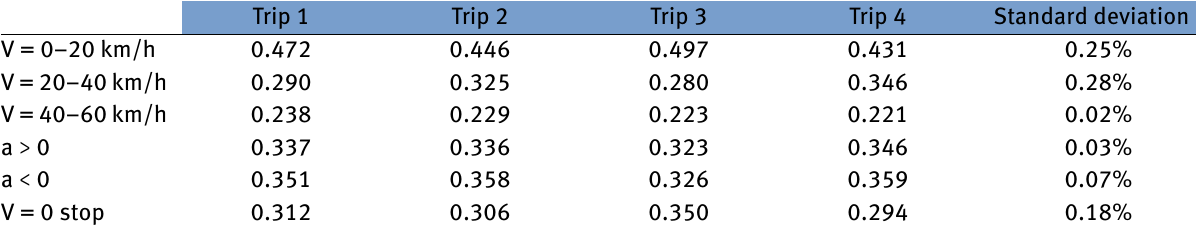
Table 3: Comparison of travel parameters of a bus trip with a diesel engine.